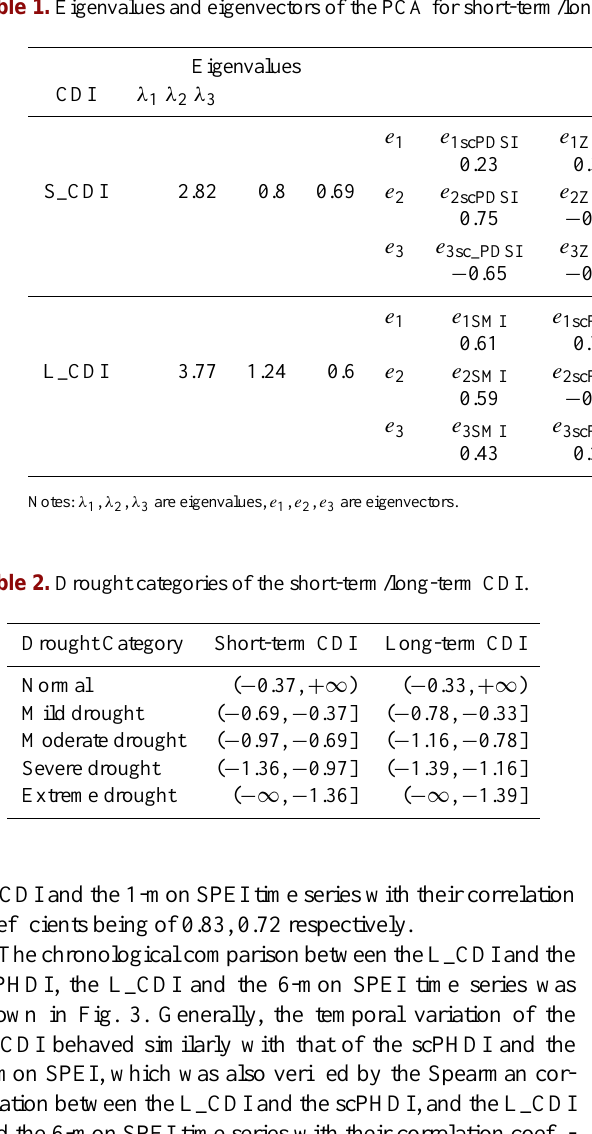
Table 1. Eigenvalues and eigenvectors of the PCA for short-term/long-term CDI in the upper Huaihe River basin. Eigenvalues Eigenvalues e 1 , e 2 , e 3 CDI